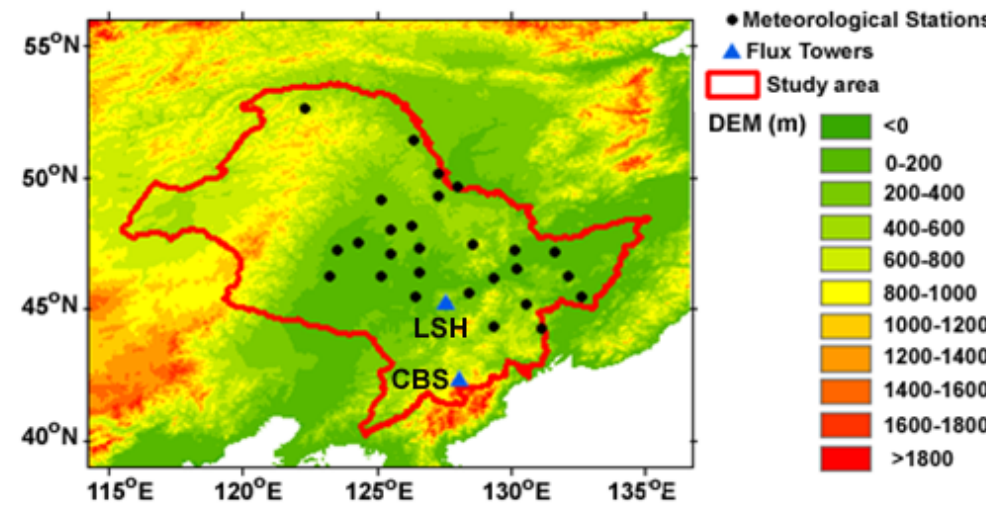
Figure 1. Study area. LSH: Laoshan, CBS: